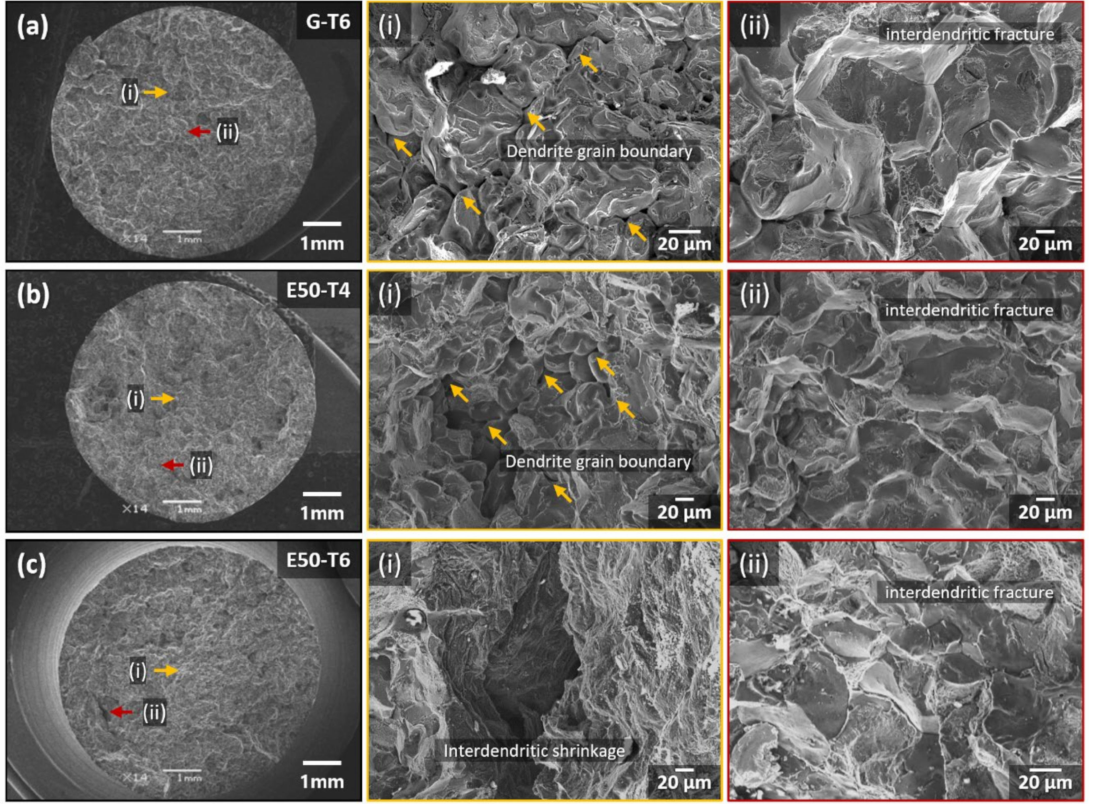
Figure 5. Fractography of the tensile tested ( a ) G-T6, ( b ) E50-T4, and ( c ) E50-T6 specimens. Yellow arrows indicate the intergranular/interdendritic